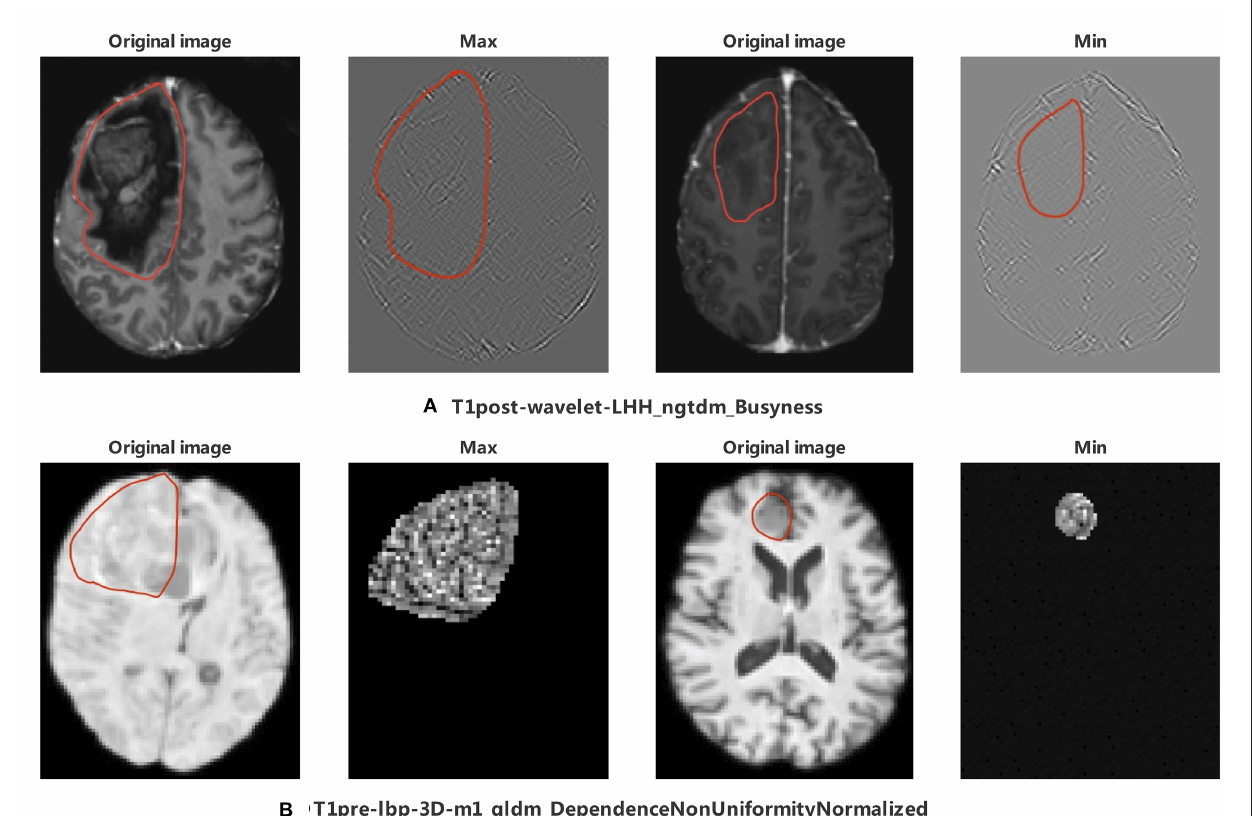
FIGURE 9 | The appearance of the MR image corresponds to top 2 radiomics features in Oligodendroglioma. The region encircled in red represents the legion boundary. (A) wavelet images and corresponding original images of the maximum and minimum value of T1post-wavelet_LHH_ngtdm_Busyness. (B) LBP images and corresponding original images of the maximum and minimum value of T1pre-lbp-3D-m1_gldm_DependenceNonUniformityNormalized. LBP image only included mask region in PyRadiomics (